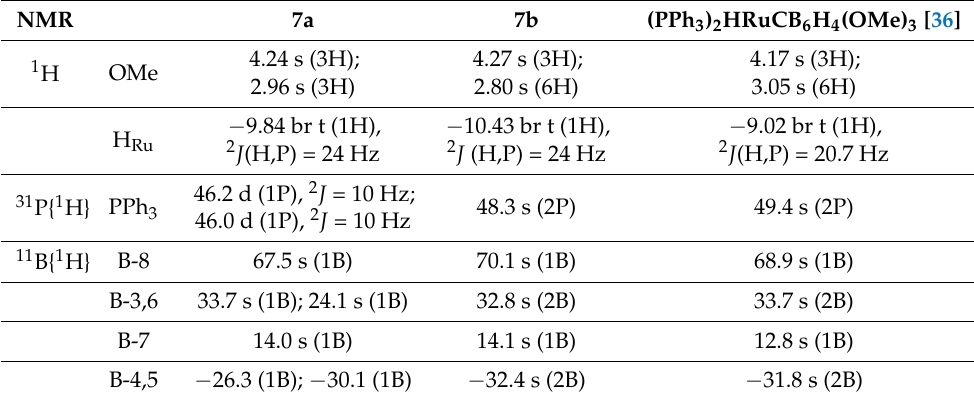
Table 1. Selected NMR Data for 7a,b and capped closo -2,2-(PPh 3 ) 2 -2-H-3,6,8-(OMe) 3 -2,1-RuCB 6 H 4 .